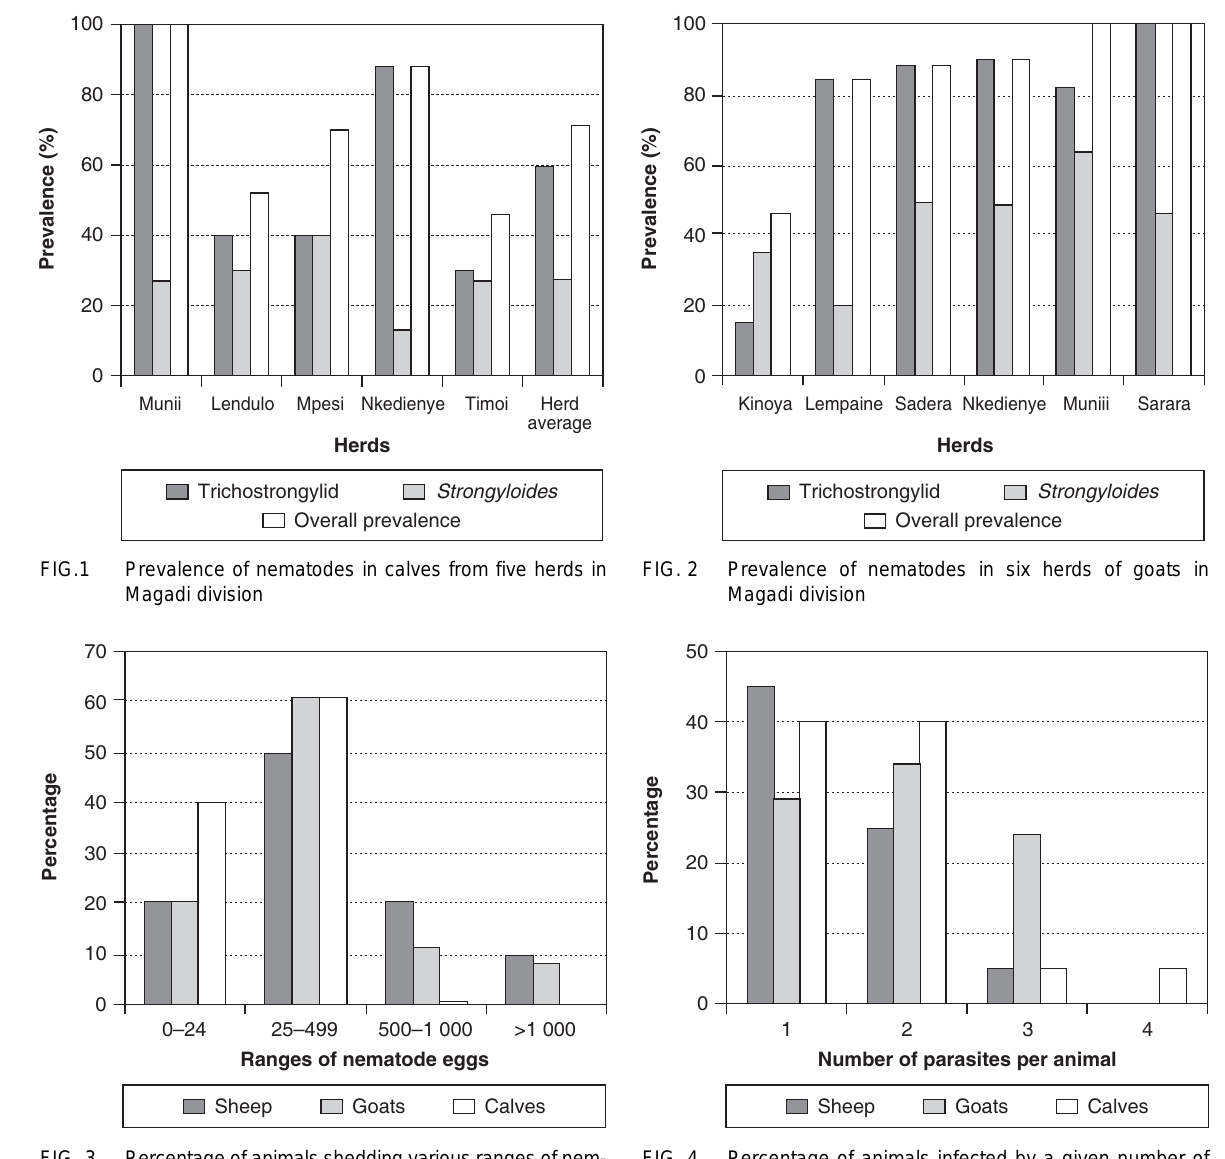
FIG. 3 Percentage of animals shedding various ranges of nem- atode eggs